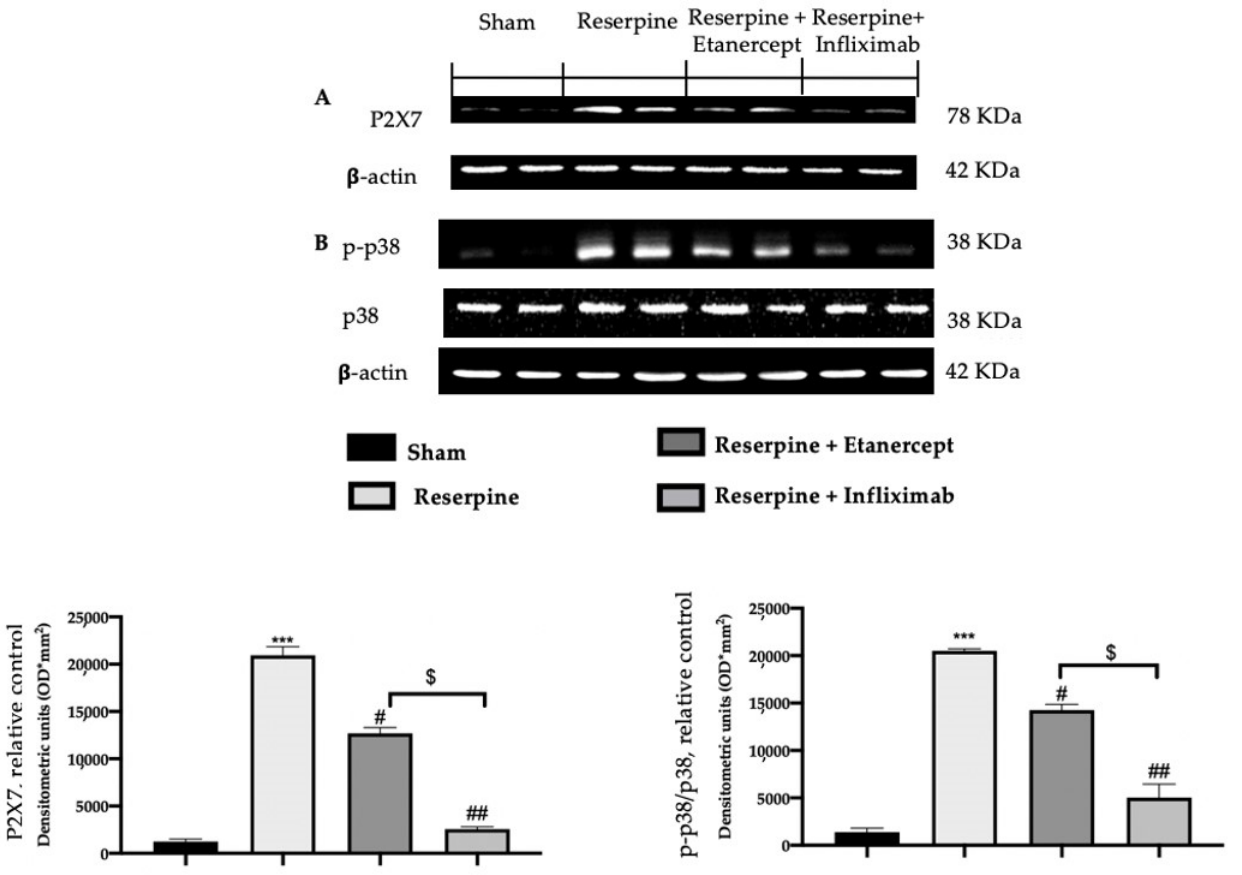
Figure 6. Efficacy of etanercept and infliximab administration on P2X7 and phospo-p38 overexpression reserpine induced. Western Blot analysis of: ( A ) P2X7 and ( B ) phospo-p38 expressions. For these analyses n = 5 animals for each group were employed. Shown is a representative blot of lysates from five animals per group, together with a densitometric analysis normalized to housekeeping proteins. Results were analysed by one-way ANOVA followed by a Bonferroni post-hoc test for multiple comparisons. A p -value <0.05 was considered significant. # p < 0.05 vs. vehicle, ## p < 0.01 vs. vehicle, *** p < 0.001 vs. sham, $ p < 0.05 infliximab vs. etanercept.